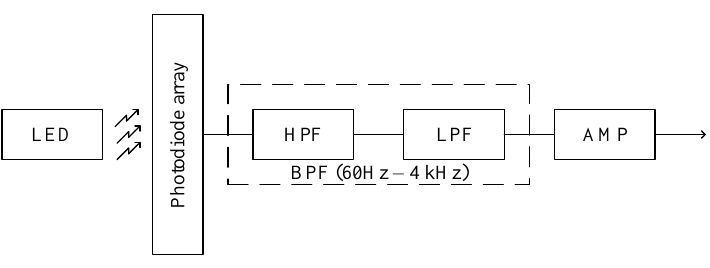
Figure 5. Block diagram of the optoelectronic system.